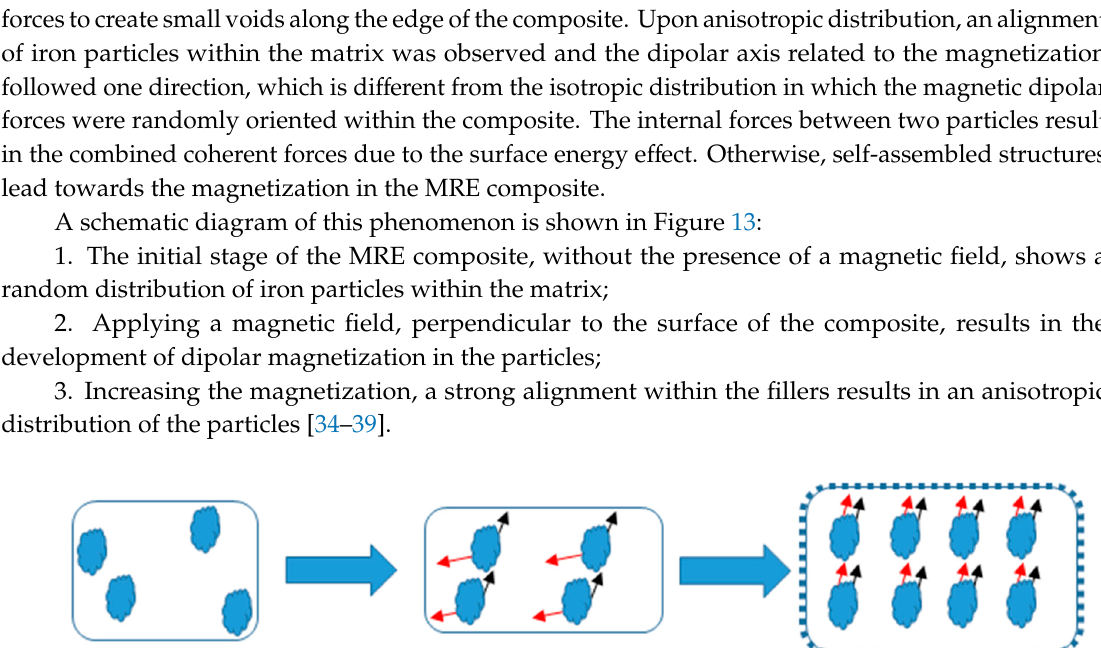
Figure 13. Iron particle distribution before and after the application of the magnetic field. 205